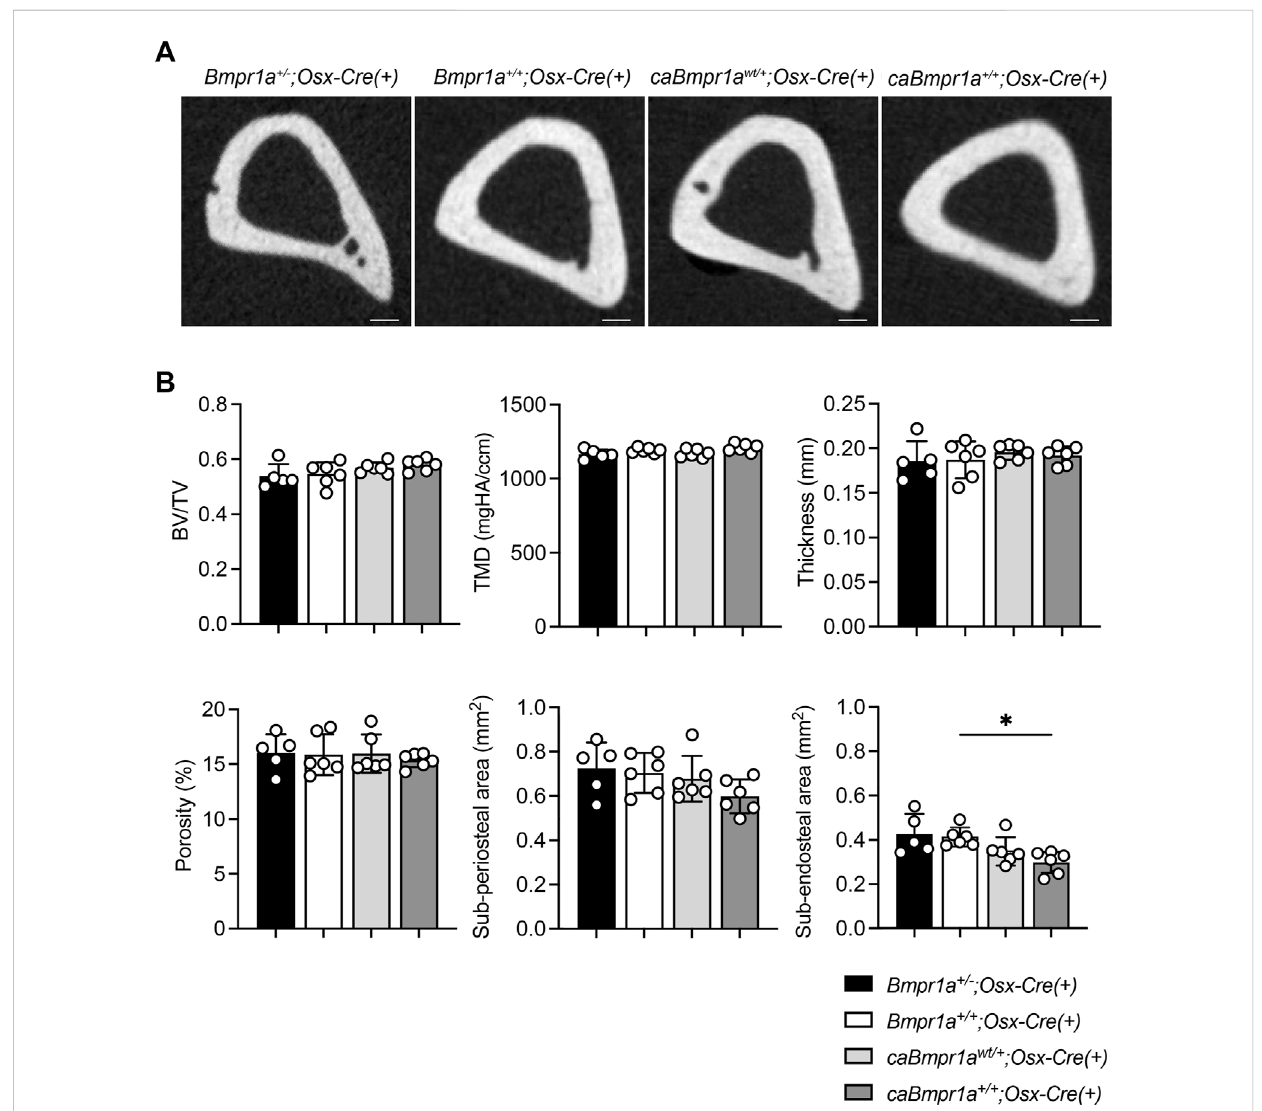
FIGURE 3 Micro-CTanalysisforcorticalcompartmentsofthemalemousetibiaat12 weeksofage. (A) Micro-CTbased2Dimagesofthemouseproximaltibia. Scale bar = 200 µm. (B) Bone volume (BV/TV), tissue mineral density (TMD), thickness, porosity, sub-periosteal (total) area and sub-endosteal (marrow) area were analyzed (n = 5 male for Bmpr1a +/ − ;Osx-Cre mice, n = 6 male for Bmpr1a +/+ ;Osx-Cre, caBmpr1a wt/+ ;Osx-Cre, caBmpr1a +/+ ;Osx-Cre mice). ** p <